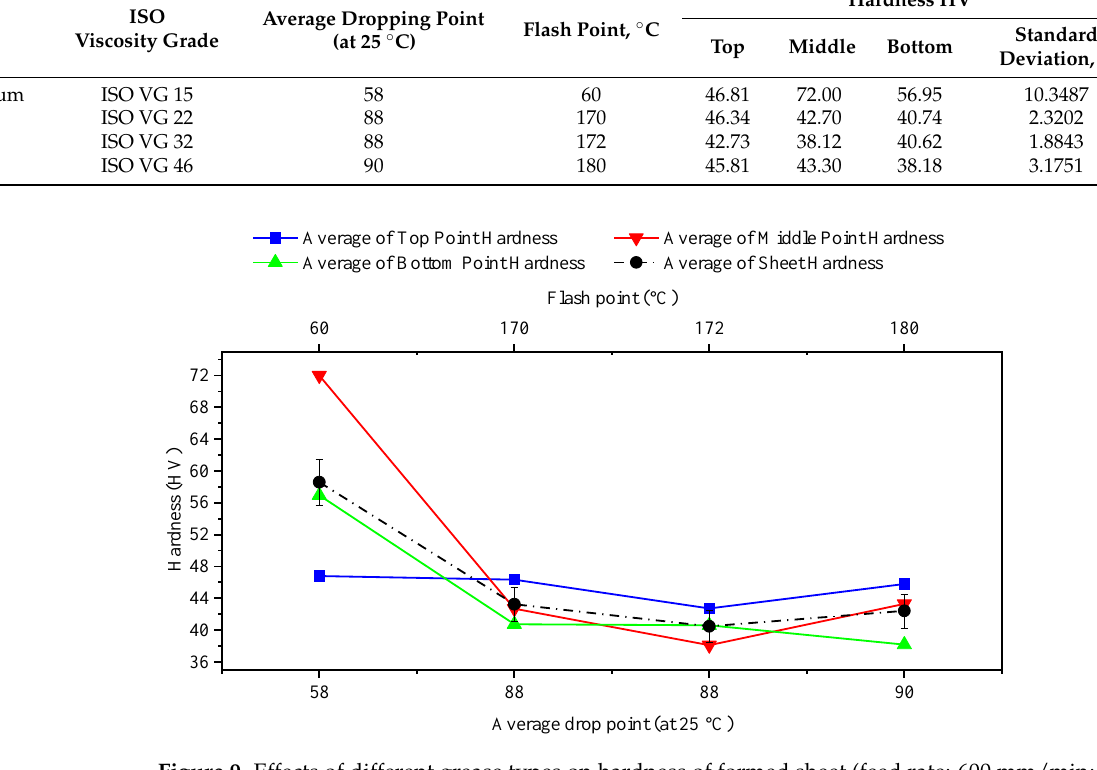
Figure 9. Effects of different grease types on hardness of formed sheet (feed rate: 600 mm/min; tool speed: 2000 rpm; tool diameter: 10 mm).